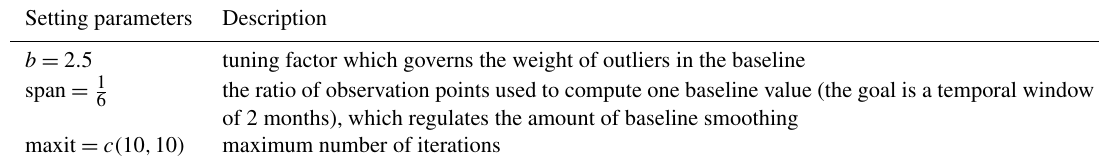
Table A3. Setting parameters of the REBS method. For more information, see Ruckstuhl et al. (2012). Setting